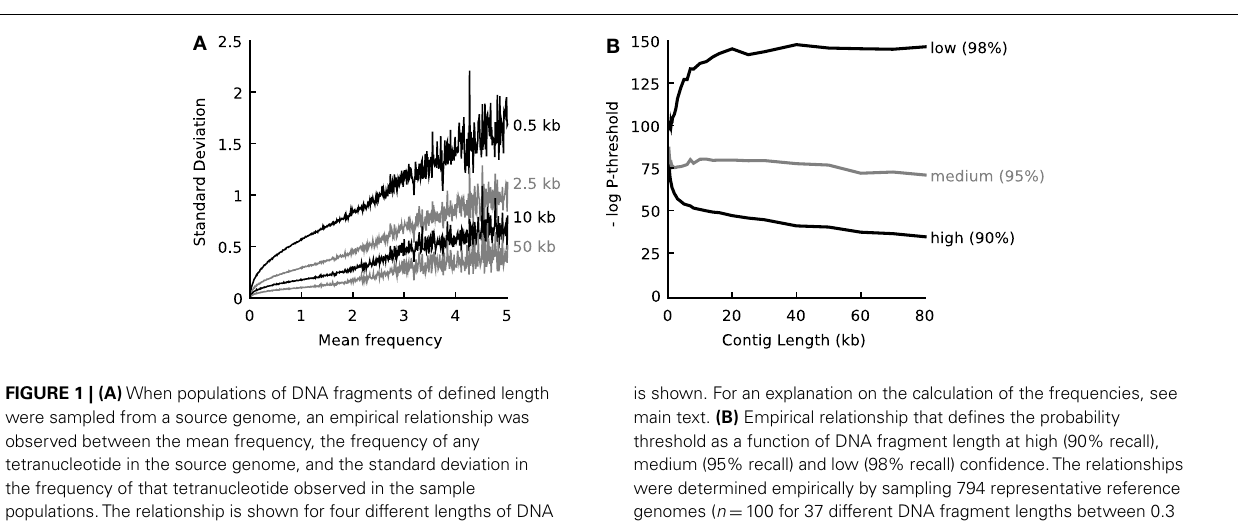
FIGURE 1 | (A) When populations of DNA fragments of defined length were sampled from a source genome, an empirical relationship was observed between the mean frequency, the frequency of any tetranucleotide in the source genome, and the standard deviation in the frequency of that tetranucleotide observed in the sample populations.The relationship is shown for four different lengths of DNA fragments and at each mean frequency the average standard deviation